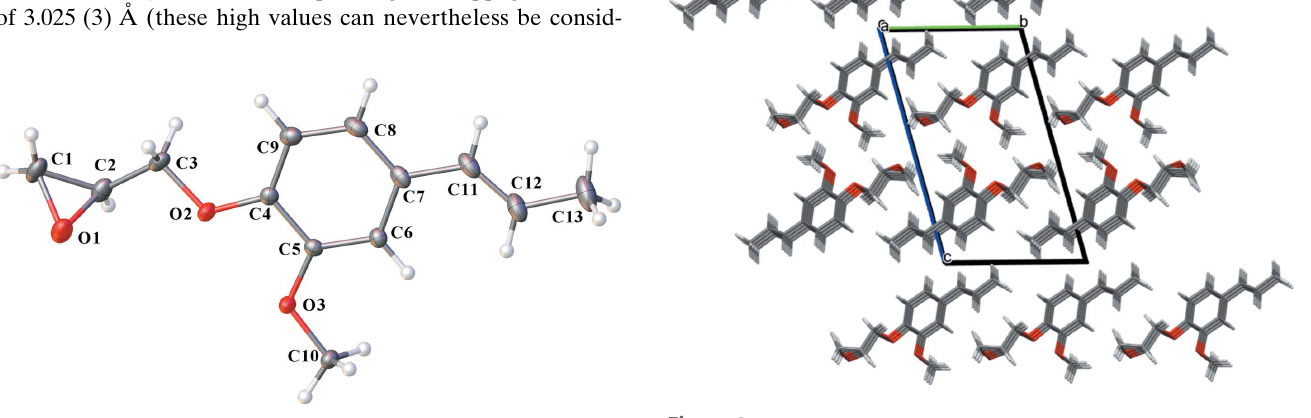
Figure 1 The molecular structure of GE-isoEu with displacement ellipsoids at the 30% probability level.